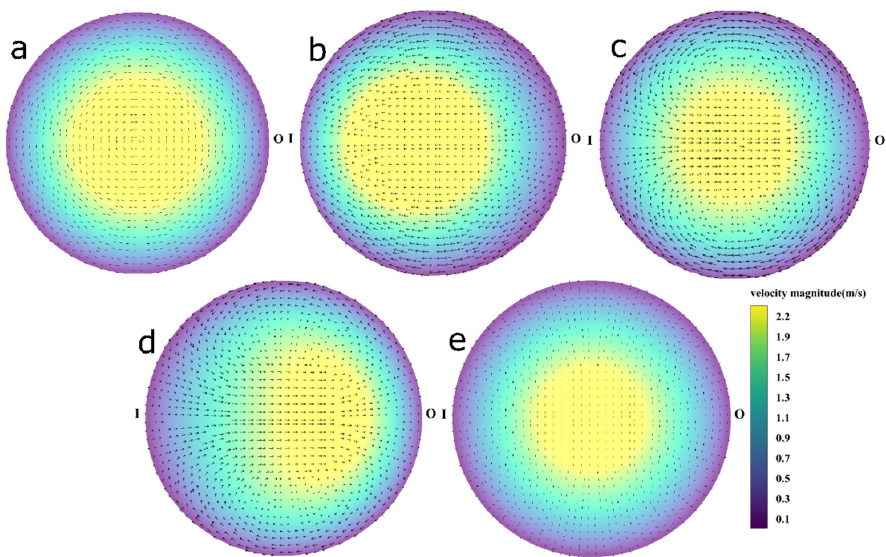
Figure 17. In the 45 ◦ channel at the conveying rate of 2.85 cm 3 /s, ( a – e ) are the profiles of the velocity magnitude and the velocity vectors on the five slices as indicated in Figure